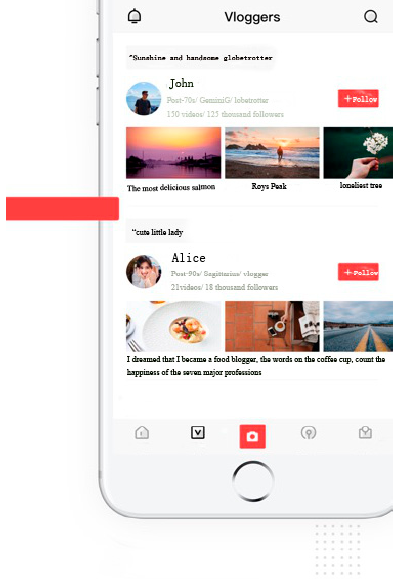
Figure 1. The main interface of VUE Vlog.